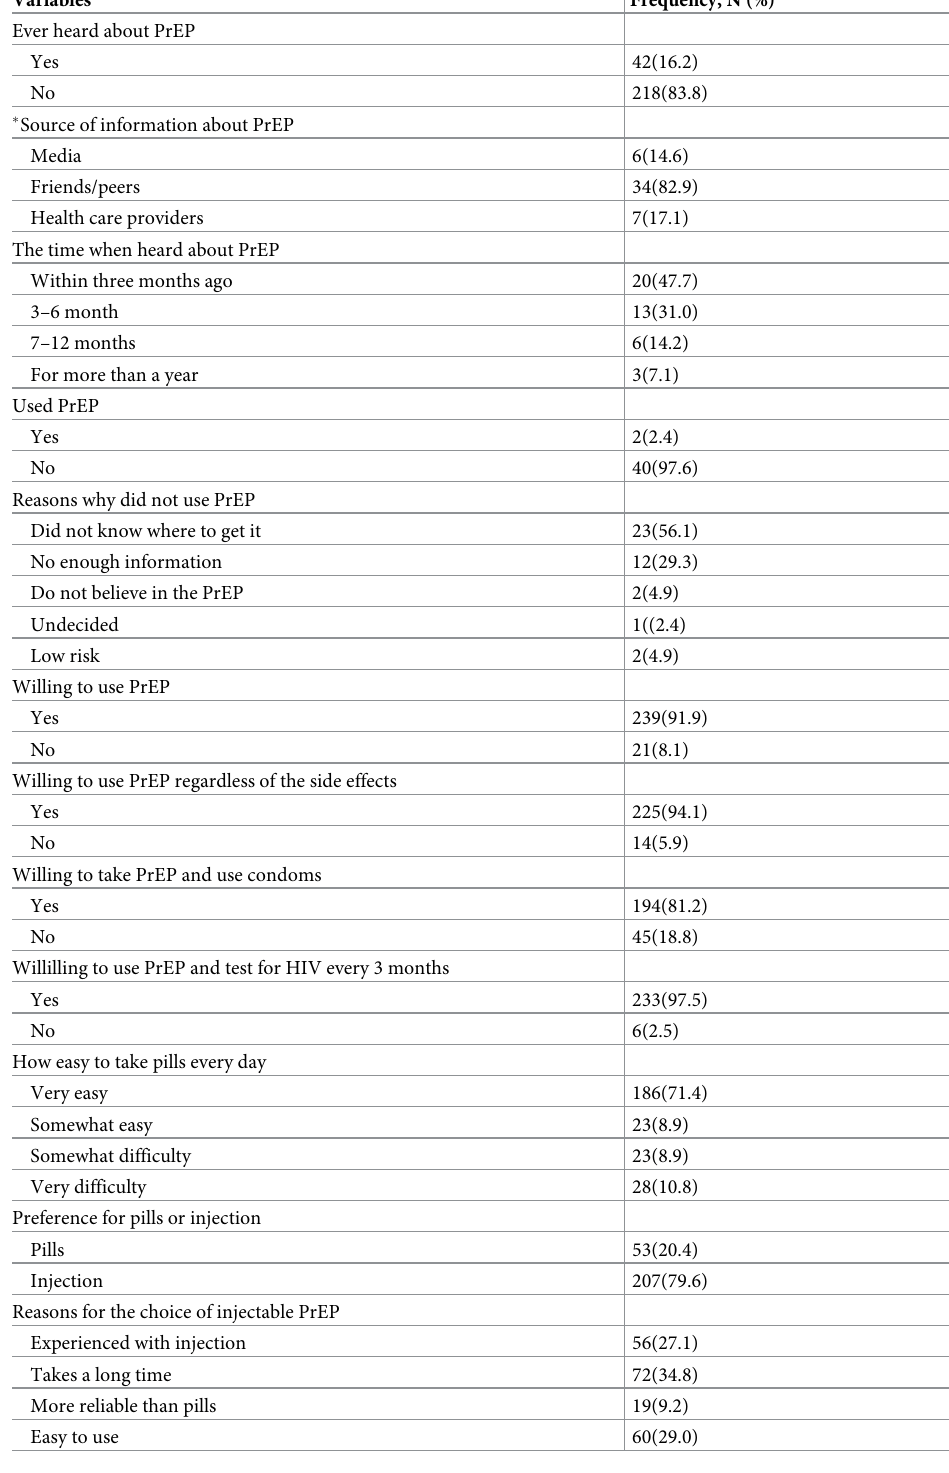
Table 4. Awareness and willingness to use PrEP among PWIDs (N =